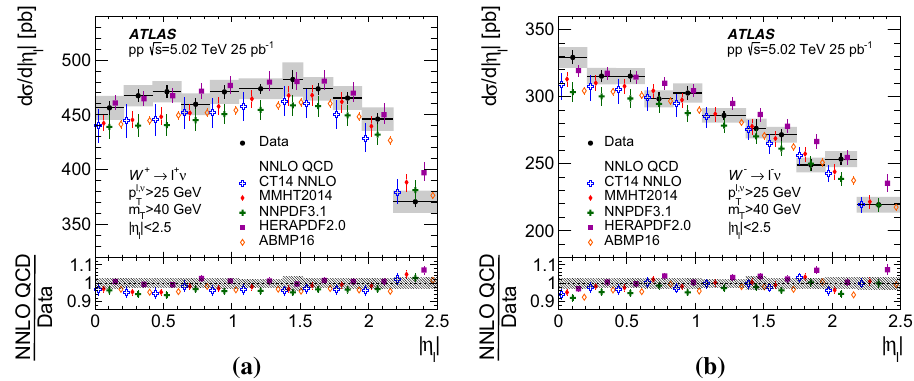
is displayed for the theory. The lower panel shows the ratio of predic- tions to the measured differential cross section in each bin, and the shaded band shows the sum in quadrature of statistical and systematic uncertainties of the data